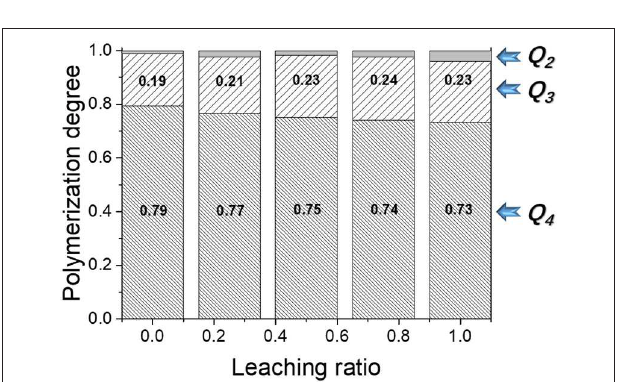
FIGURE 6 | The degree of polymerization evolution with leaching ratio. Q n is the polymerization factor, where n can be 0, 1, 2, 3, or, 4, representing the number of bridging oxygens for a given Si/Al tetrahedron. Q 0 means monomer, Q 1 stands for dimer, Q 2 represents a chain structure, and Q 3 and Q 4 are branch structure and network structure,